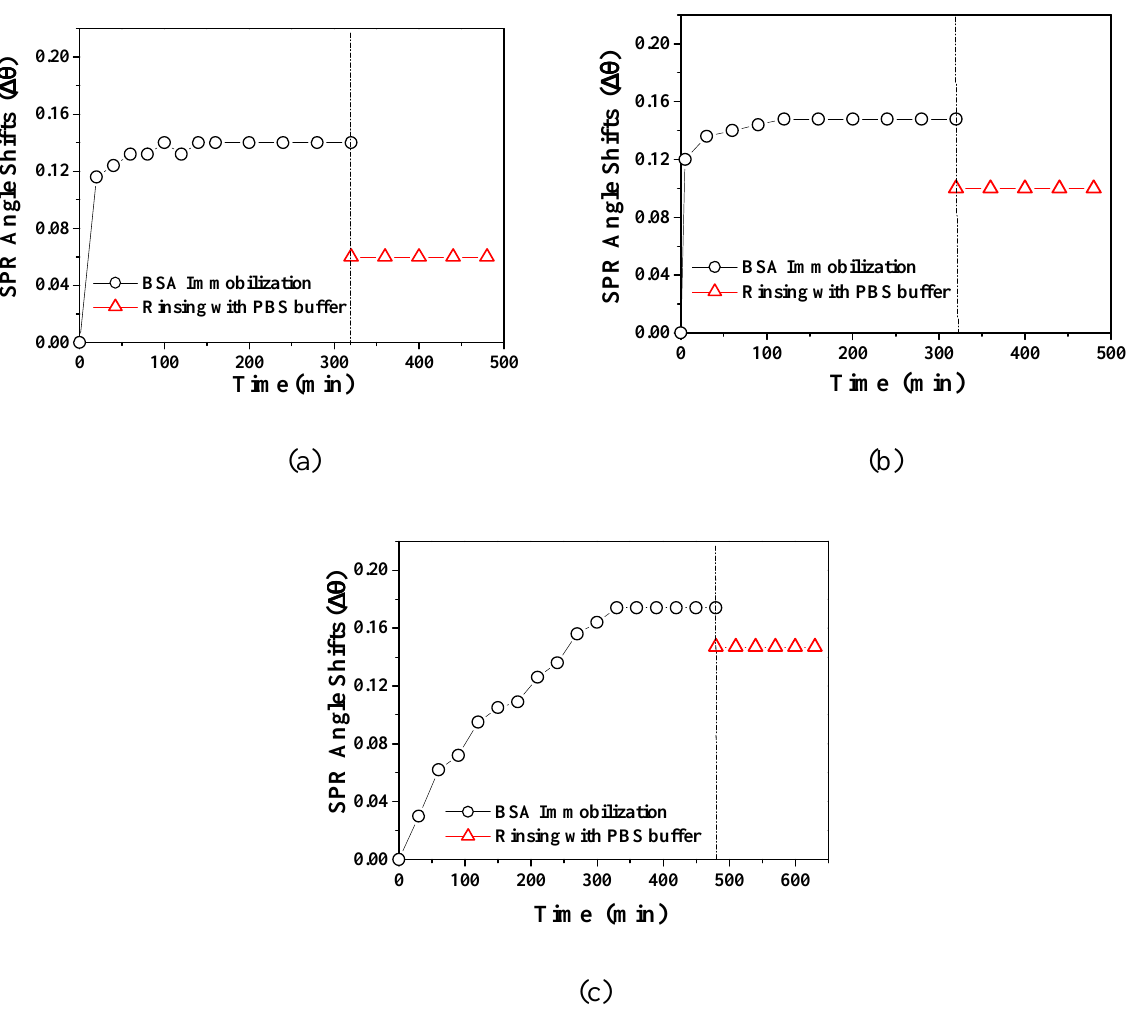
Figure 8 . SPR angle shifts according to the immobilization of BSA on (a) Cal-4 derivative 1 SAM, (b) Cal-4 derivative 2 SAM, and (c) Cal-4 derivative 3